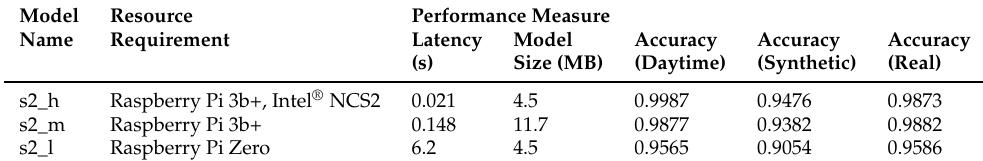
Table 6. Performance results of the recognition model.